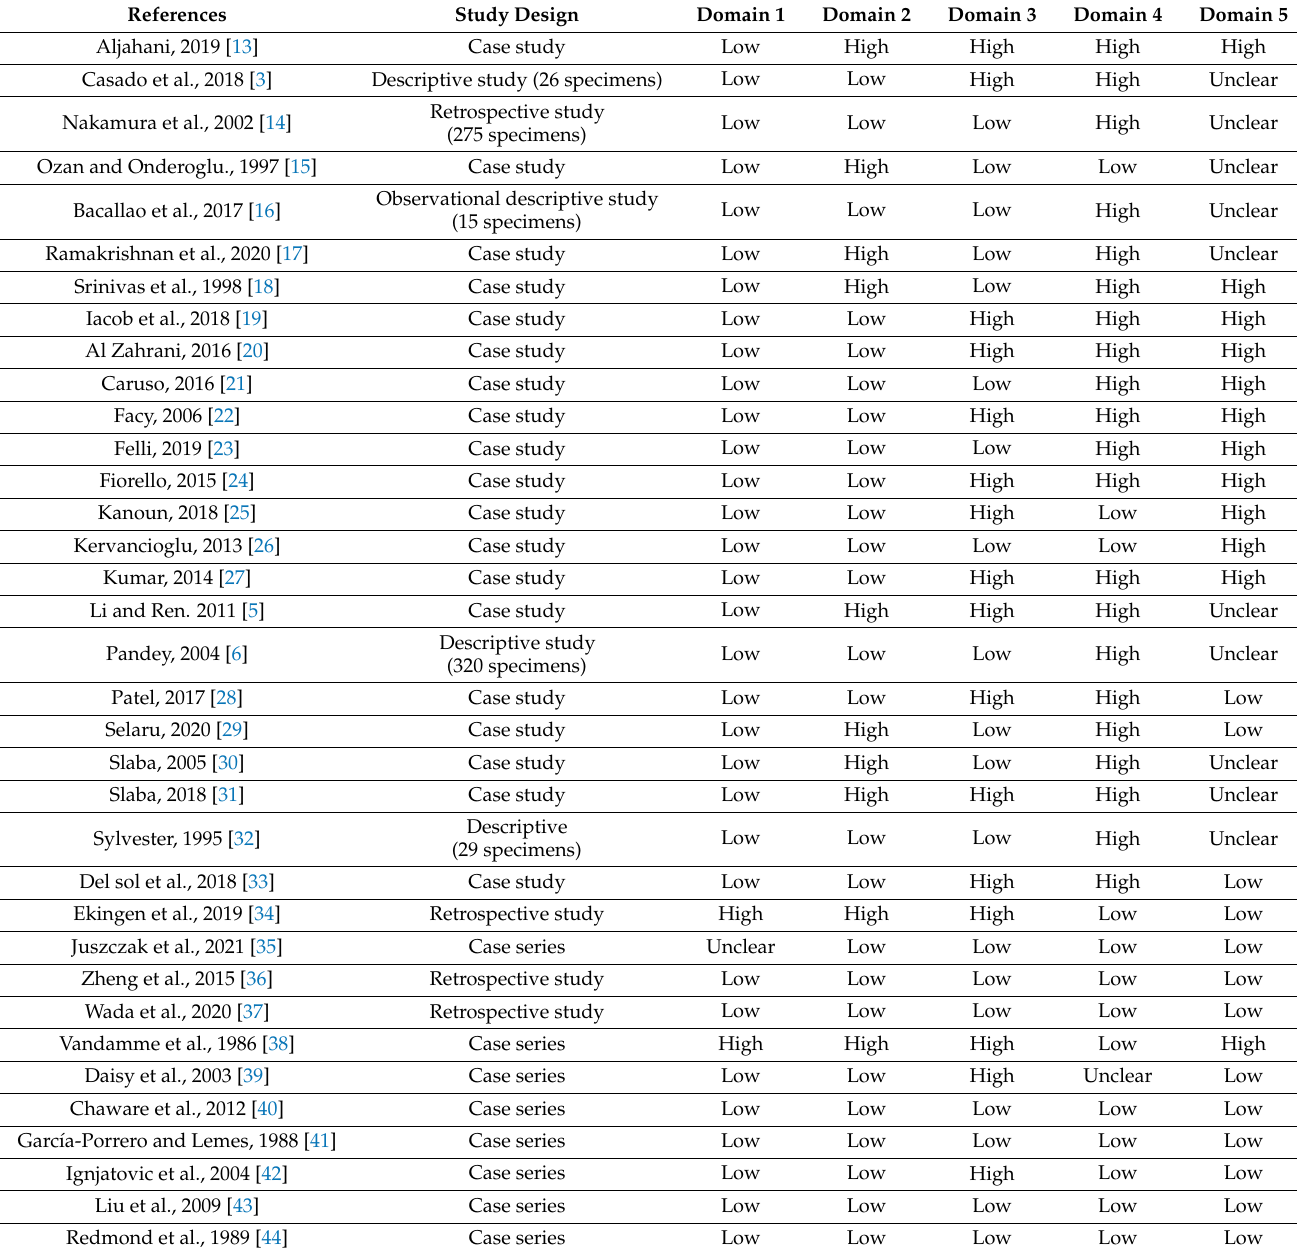
Table 1. Anatomical quality assurance